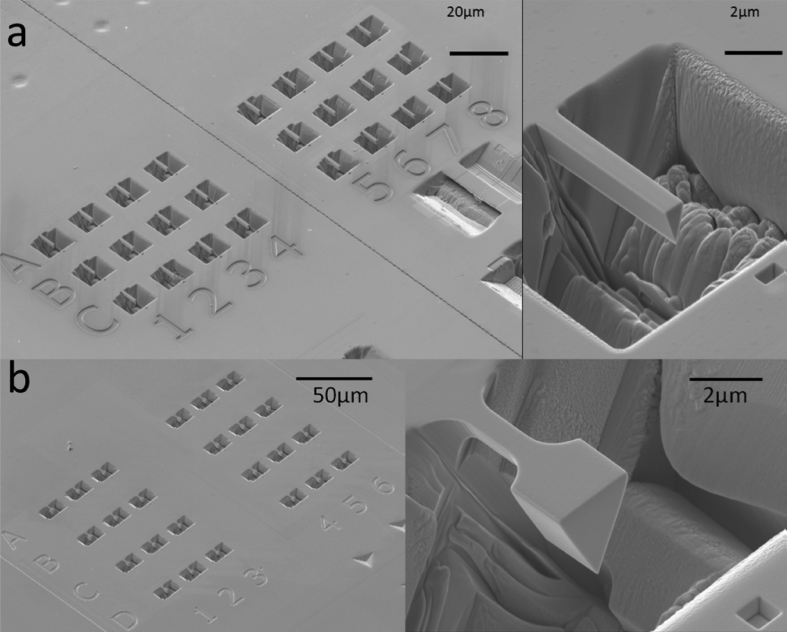
Example SEM images of micro-cantilever arrays fabricated by FIB: (a) uniform cross-section; (b) waisted cross-section. From Armstrong et al. [2015].44